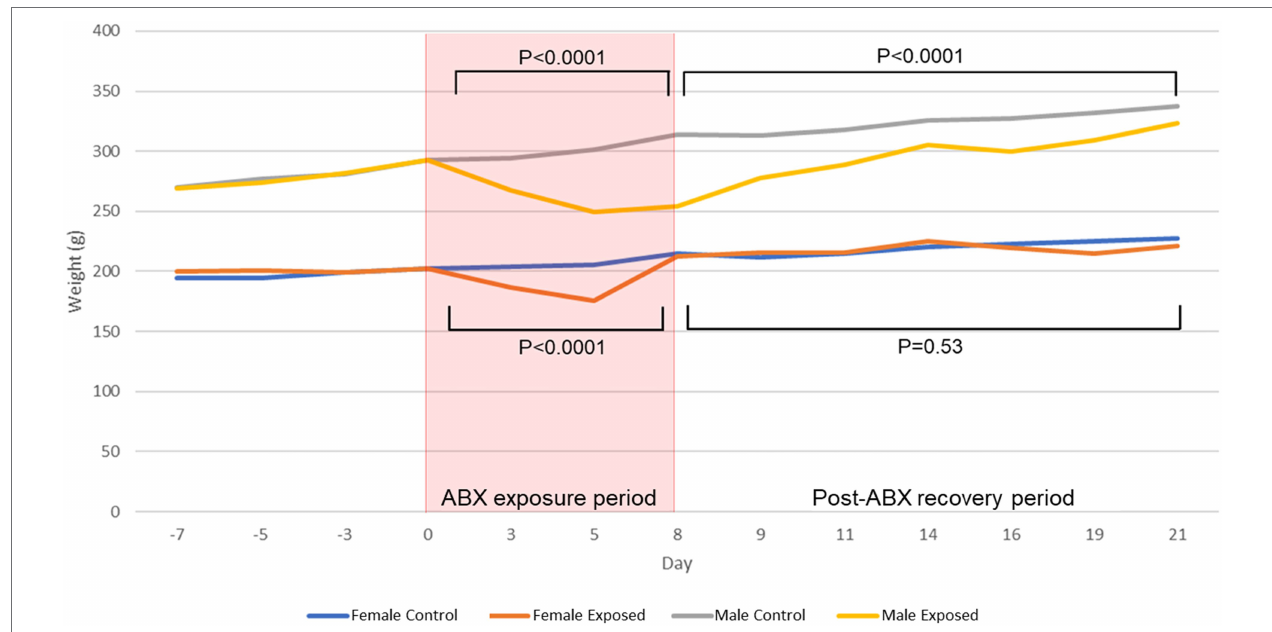
FIGURE 1 | Average weights in male and female control and antibiotic-exposed rats at baseline, during the 8-day antibiotic exposure period, and during the 13- day recovery period following cessation of antibiotics. P values denote differences between antibiotic-exposed rats and controls of the same sex during the antibiotic-exposure and recovery